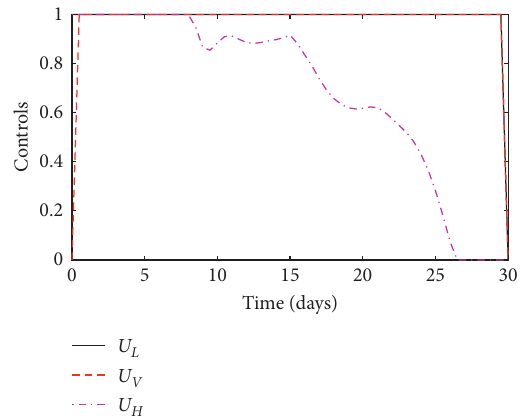
Figure 3: Simulation results of the control profile of model (15) using the maximum mean temperature of 25 . 32 ° C in KwaZulu- Natal, South